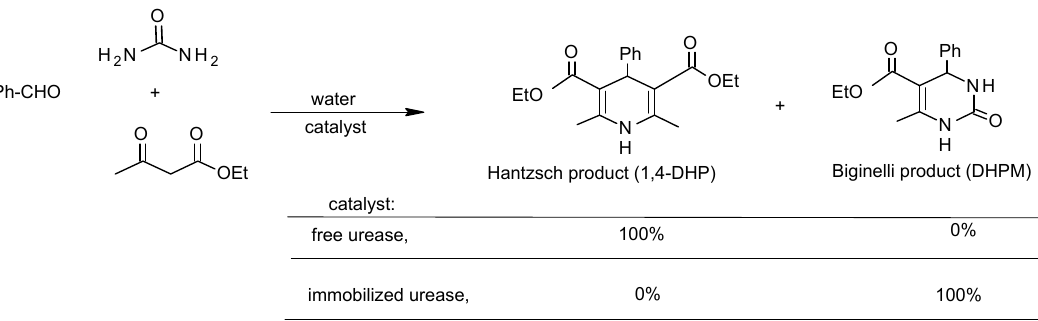
Scheme 8. Catalytic effect of free and immobilized urease, leading to Biginelli and Hantzsch products. DHP: 1,4-dihydropyridine and DHPM: 3,4-dihydropyrimidin-2(1 H